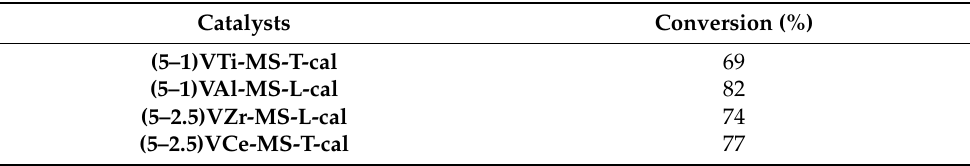
Table 3. Conversion of meso -hydrobenzoin with vanadium stabilized by different